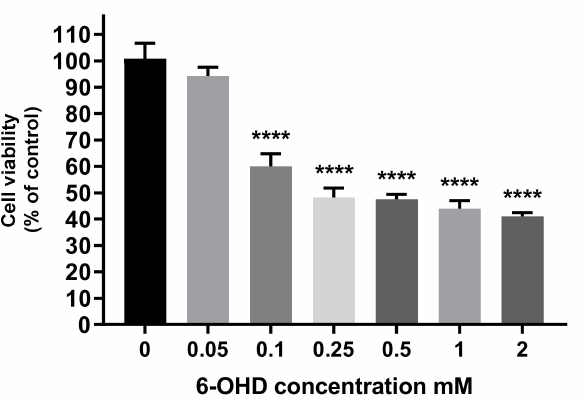
Figure 13. Effect of 6-OHD 48-h treatment on SH-SH5Y cells. Cell viability was measured by the MTT assay. Data are presented as the Mean ± SEM of three independent experiments carried out in quadruplicate. **** p < 0.0001 vs. vehicle-treated control cells.